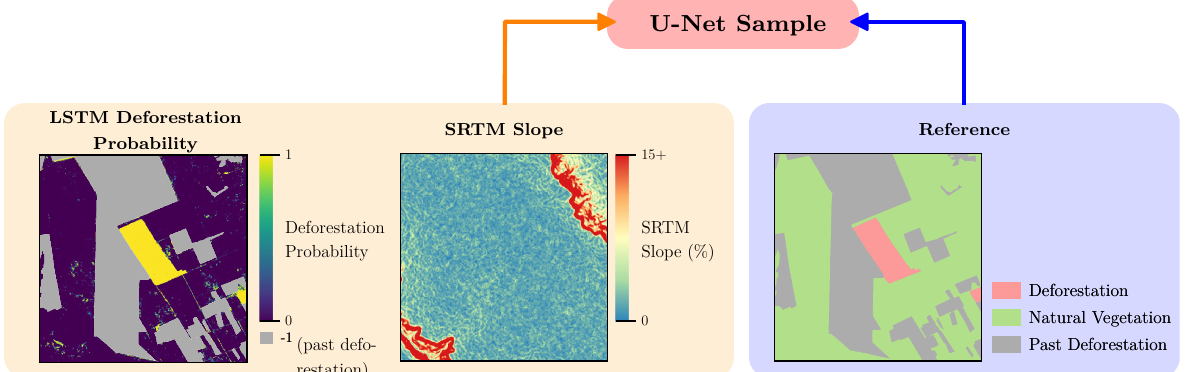
Figure 5. U-Net sample (chip): LSTM map, SRTM slope, reference deforestation. Samples have the same dimensions of 284 × 284